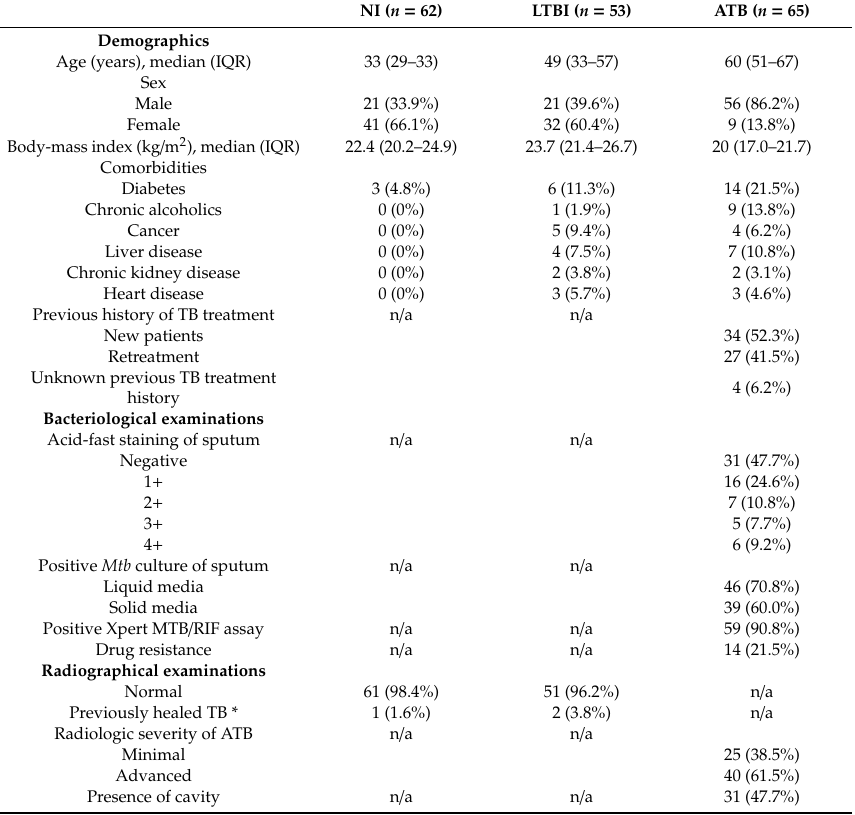
Table 1. Demographic and clinical characteristics of the study